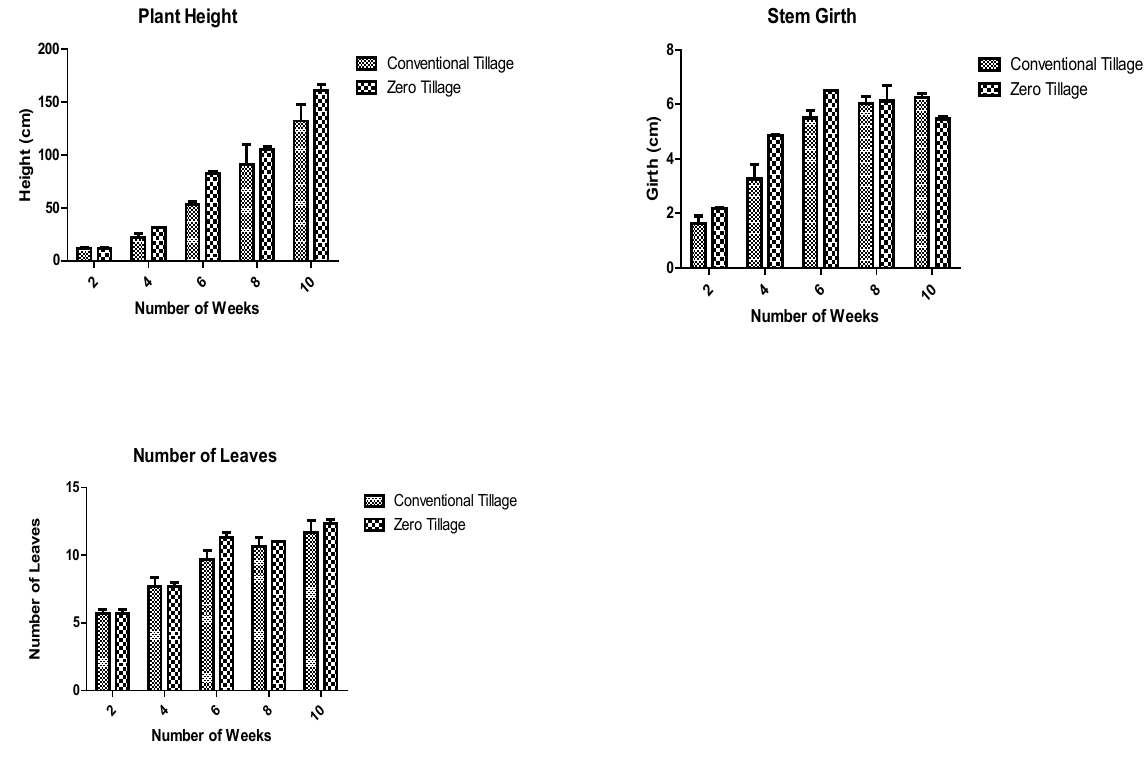
Figure 4: Growth Parameters under Different Tillage Practices during Late